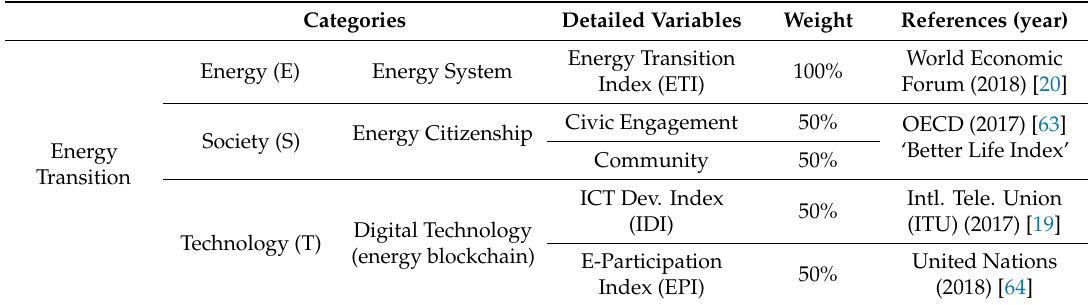
Table 1. The variable framework of the fuzzy-set ideal type